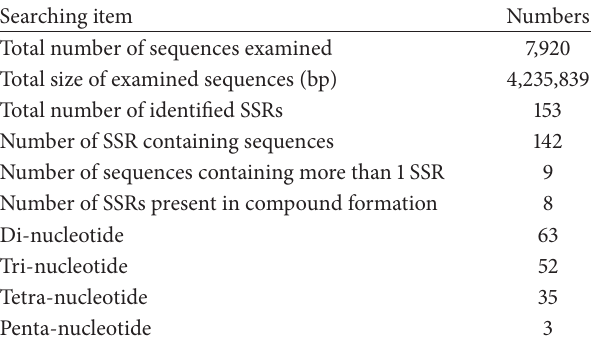
Table 8: Statistics of EST-SSRs identified in Aphanopus carbo